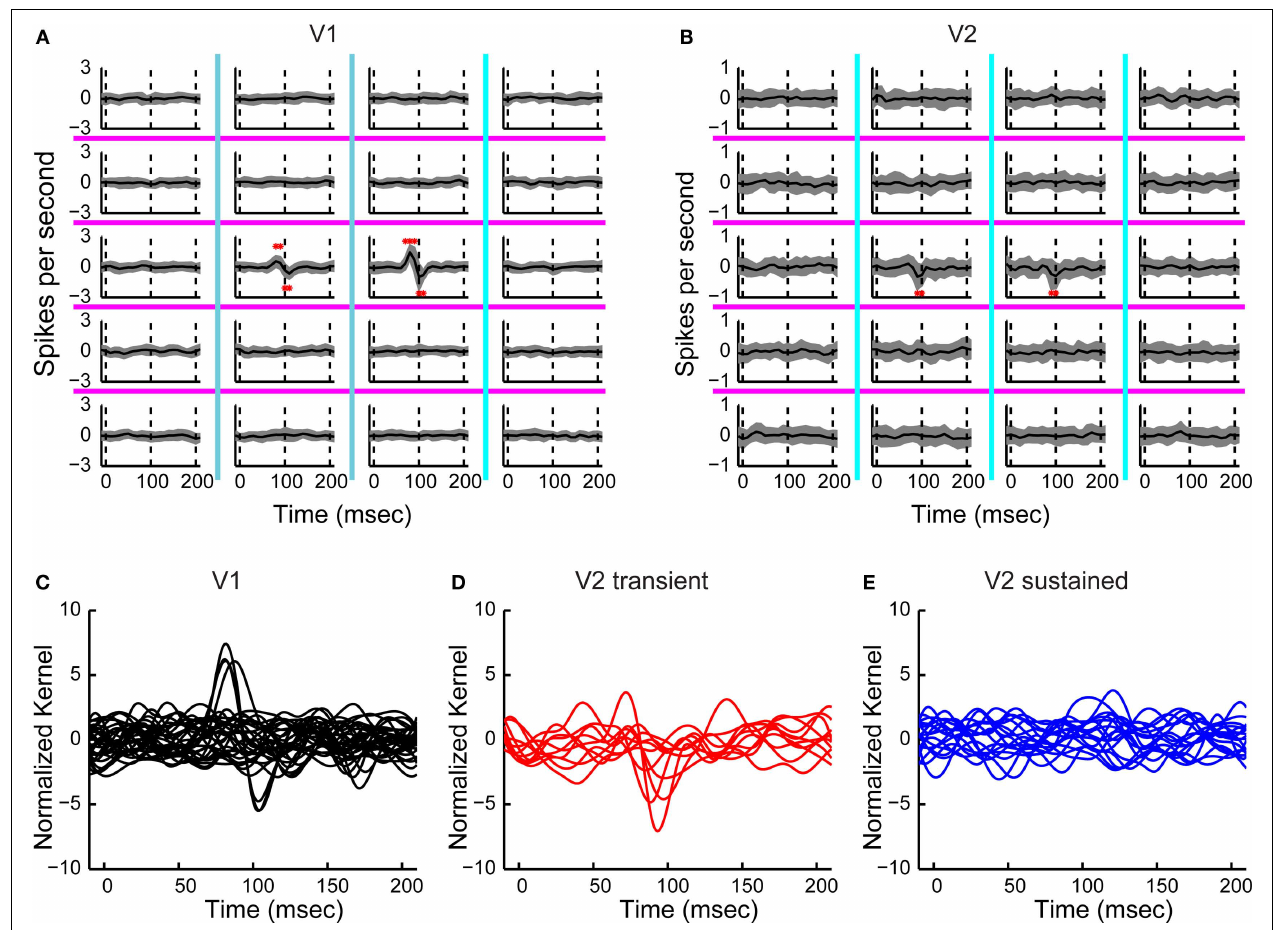
deviation in gray. Asterisks mark timepoints at which the response was signifi cantly different from zero (two-tailed t -test, α = 0.01, corrected for multiple comparisons). Dashed vertical lines show the timepoints 0, 100 and 200 ms. (B) Temporal second-order responses of a V2 neuron. The check size of the stimulus was 0.4 × 1.1 degrees per visual angle. (C) Normalized temporal second-order response kernels (largest response) for all V1 neurons. (D) Same as in (C) for V2 transient neurons. (E) Same as in (C) for V2 sustained